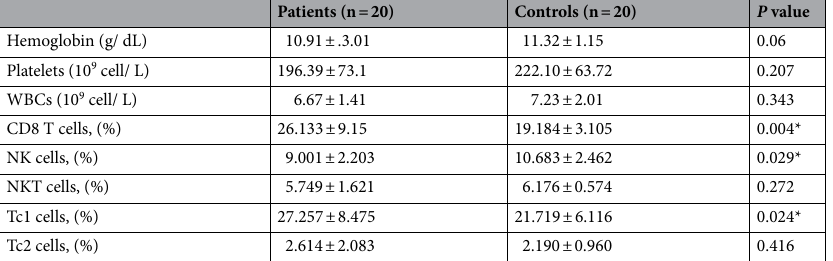
Table 2. Peripheral blood, CD8 T cells, CD8 subtypes (Tc1, Tc2), NK and NKT cells in GD patients and control. Values represent mean ± SD of the relative count of each population. Independent T-test is used in comparison between two groups. n number, CD cluster of differentiation, (%) percentage, NK natural killer, NKT natural killer T, Tc1 T cytotoxic 1, Tc2 T cytotoxic